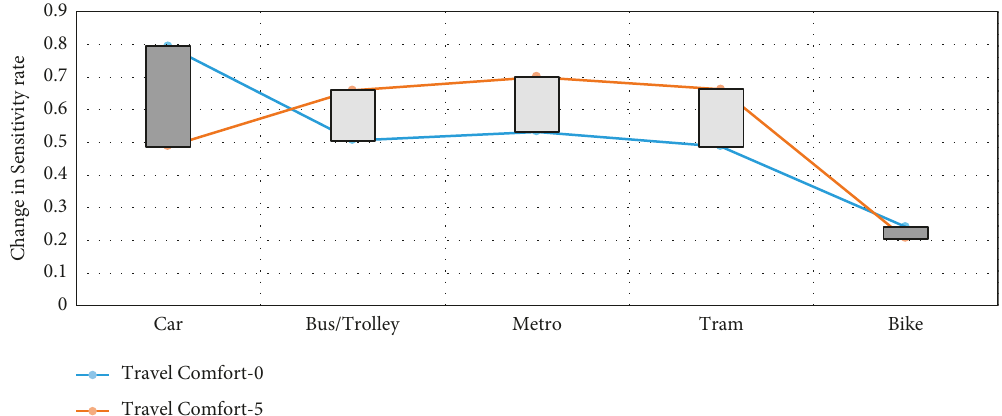
Figure 6: A comparison between the coefficients of the mode choice based on changing the comfort